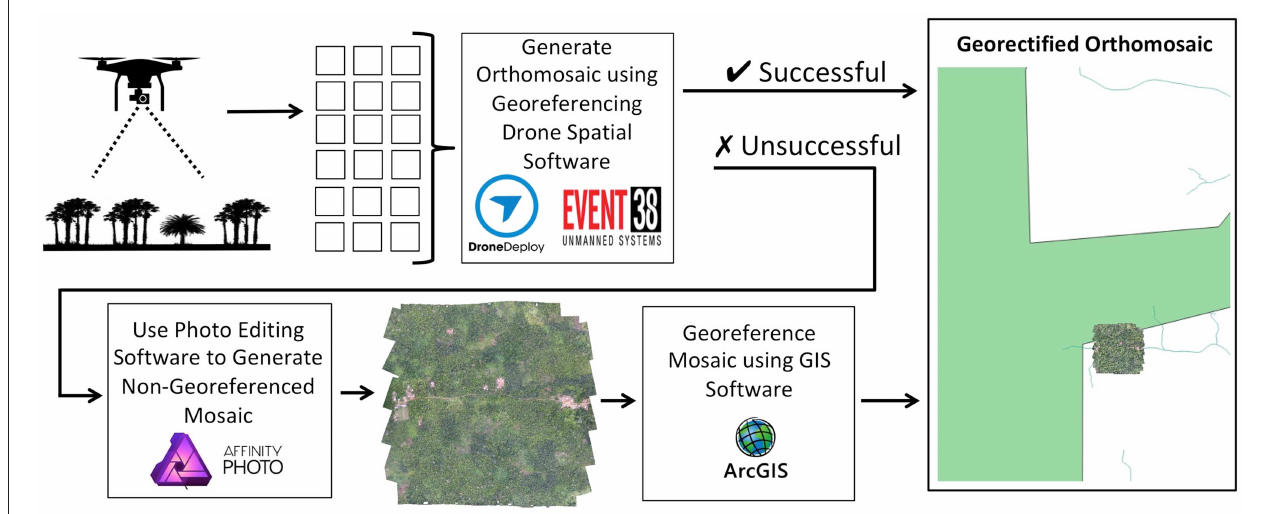
FIGURE 3 | Drone image processing workflow: data were captured from the drone as individual images. These were then fed into drone spatial software capable of generating georectified orthomosaics (i.e., Drone Deploy, Event 38 unmanned systems). If these softwares were incapable of producing an orthomosaic, the images were fed into an advanced image editing software (Affinity Photo). The resulting orthomosaic was not georeferenced, so it was then uploaded to GIS software capable of georeferencing (ArcGIS) to produce a final georectified